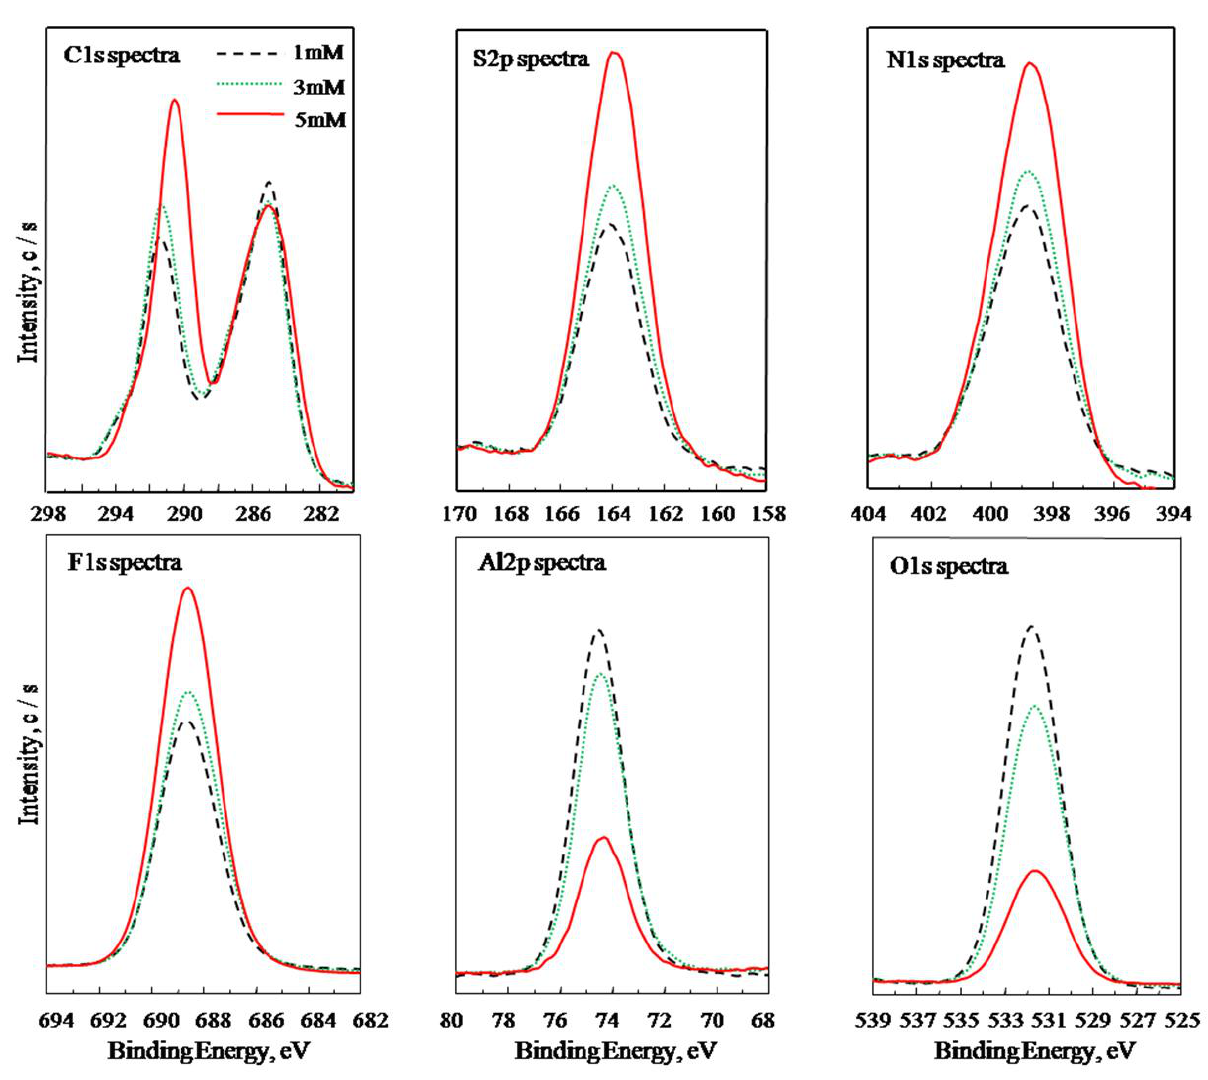
Figure 1. Effect of AF17N concentration on element intensity in the PAF17 nanofilm by XPS analysis. Electropolymerization conditions (Current density: 0.3 mA/cm 2 ; Concentration of AF17N: 1, 3, 5 mM; Electropolymerization temperature: 25 °C; Electropolymerization time: 5